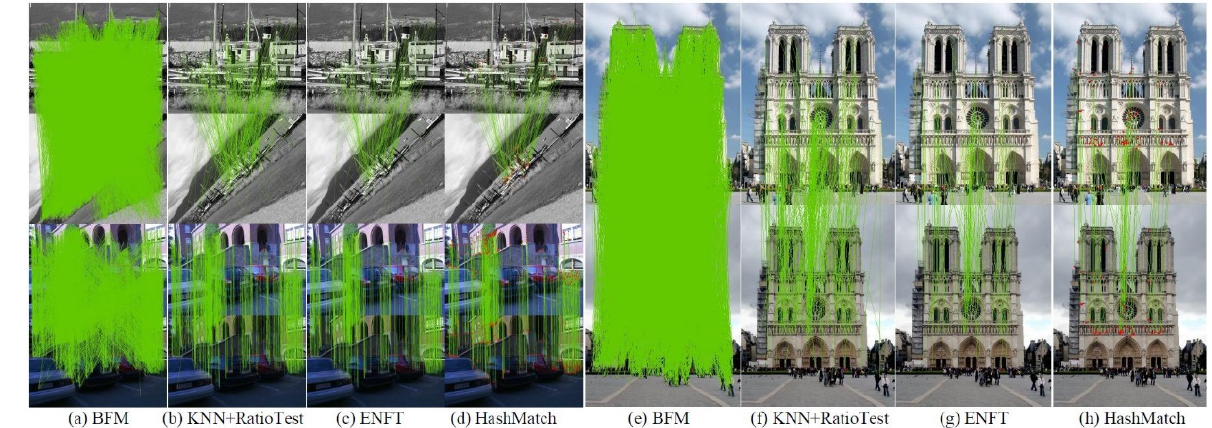
Figure 5. Image pairs from the EdgeFoci dataset.